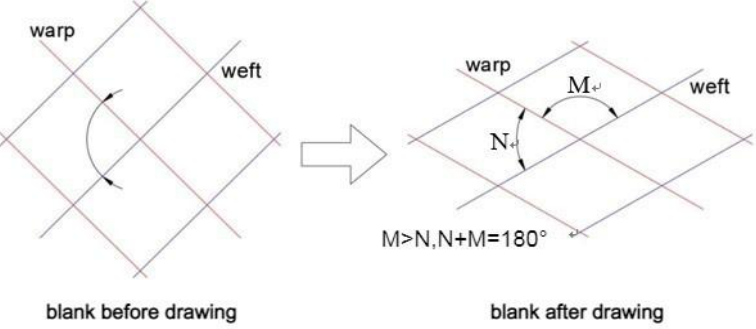
Figure 6. The definition of fiber intersection angle N after drawing and curing. Table 3. Fiber intersection angles at different points of composite specimens after drawing.